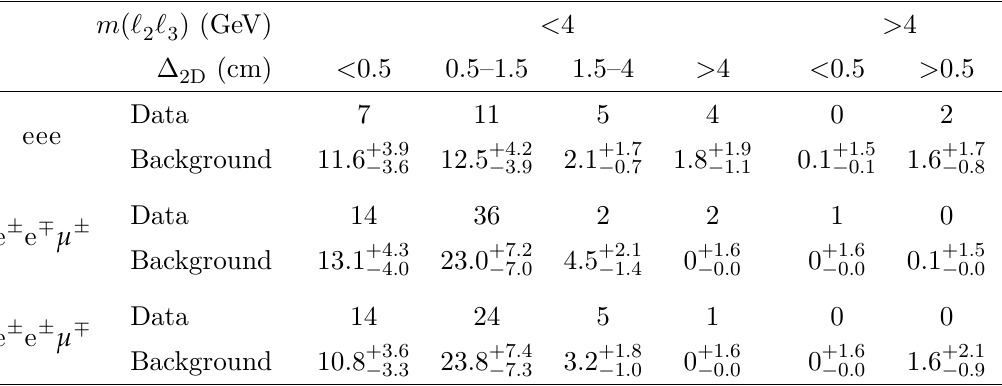
Table 3 . Number of predicted and observed events in the eeX final states. The quoted uncertainties include statistical and systematic components.